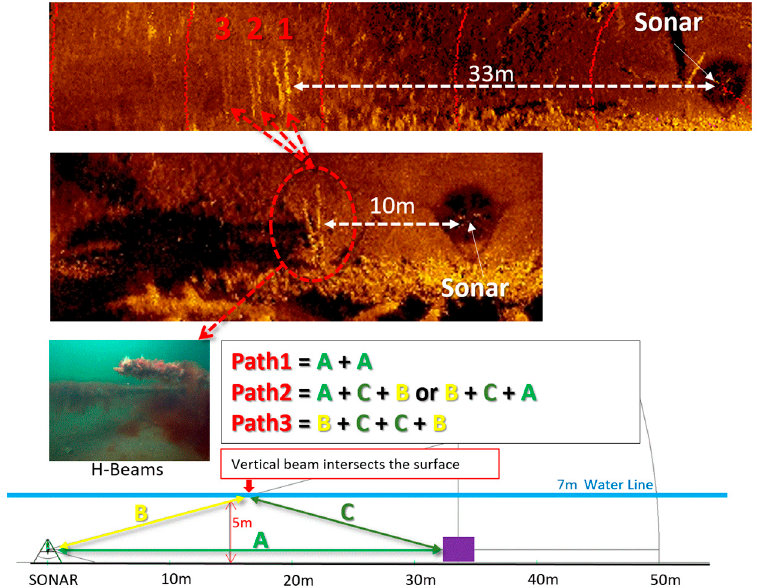
Figure 3. Multipath as seen in the sonar image.